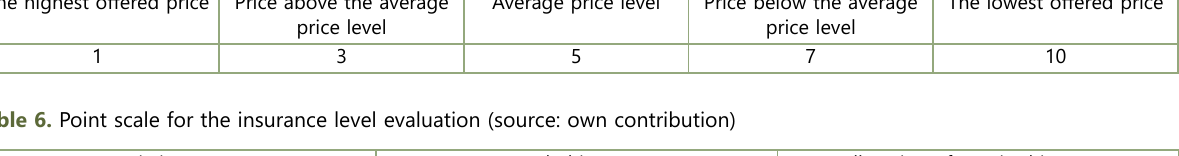
Table 5. Point scale for price criterion evaluation (source: own contribution) The highest offered price